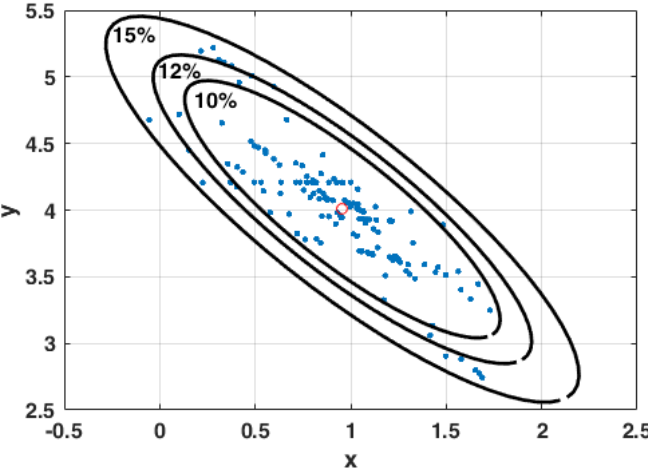
Figure 1. Example of a linear regression model. Ellipse of uncertainty for different relative misfits ranging from 10% to 15% and different sets of model parameters found in the different bagging experiments.